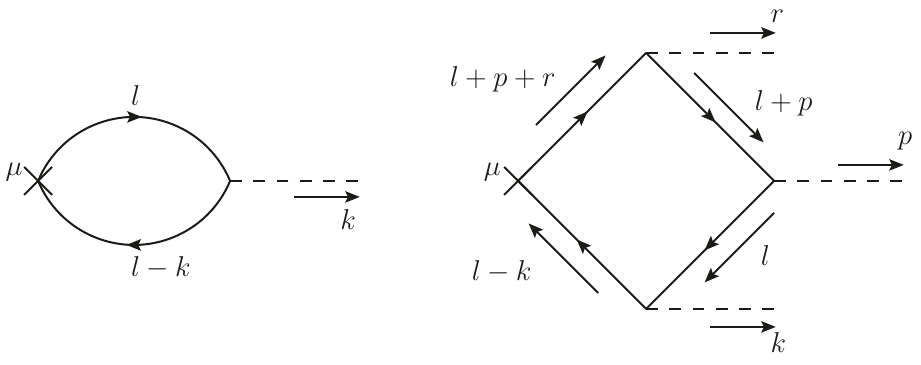
Figure 1 . Contributions to the divergence of the axial vector current due to emission of axion-like, or pseudoscalar